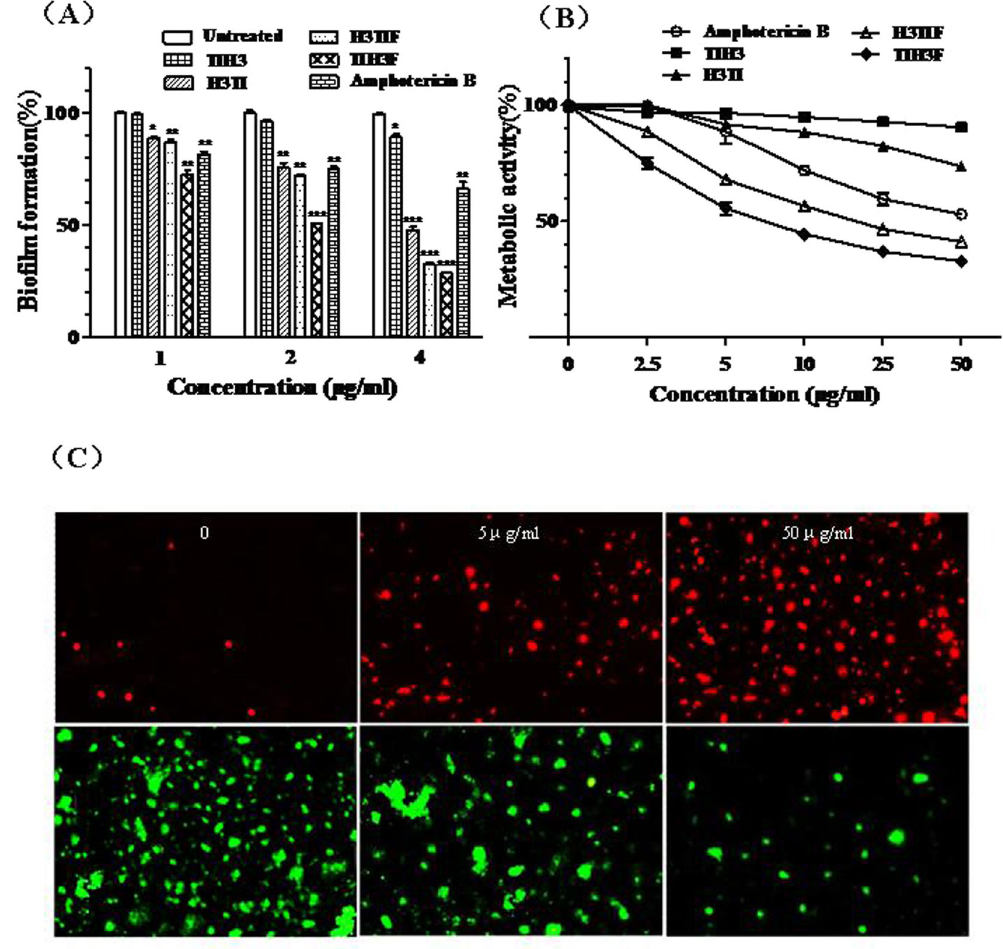
Figure 2. Activities of TIH3, H3TI, H3TIF and TIH3F inhibiting C. albicans biofilms formation and killing C. albicans in established biofilms. ( A ) The inhibitory effect of TIH3, H3TI, H3TIF and TIH3F against C. albicans biofilm formation. C. albicans was grown in a 6-well plate with coverslip at 35 °C for 36 h in the presence of different concentrations of four peptides. Growth in control is set to 100% and percent of biofilm formed is indicated in different bar. Data are presented as the mean ± SD from three independent experiments ( * P < 0.05; ** P < 0.01; *** P < 0.001; by unpaired t test). ( B ) The killing effect of four hybrid peptides against C. albicans in the biofilms. Cells treated with peptides and amphotericin B of series concentrations, with negative control set to a 100%. Data are presented as the mean ± SD from three independent experiments. ( C ) Visualization of TIH3F killing C. albicans in established biofilms photographed by fluorescence microscope. Living cells stained by SYBR Green I are green and dead cells stained by PI are